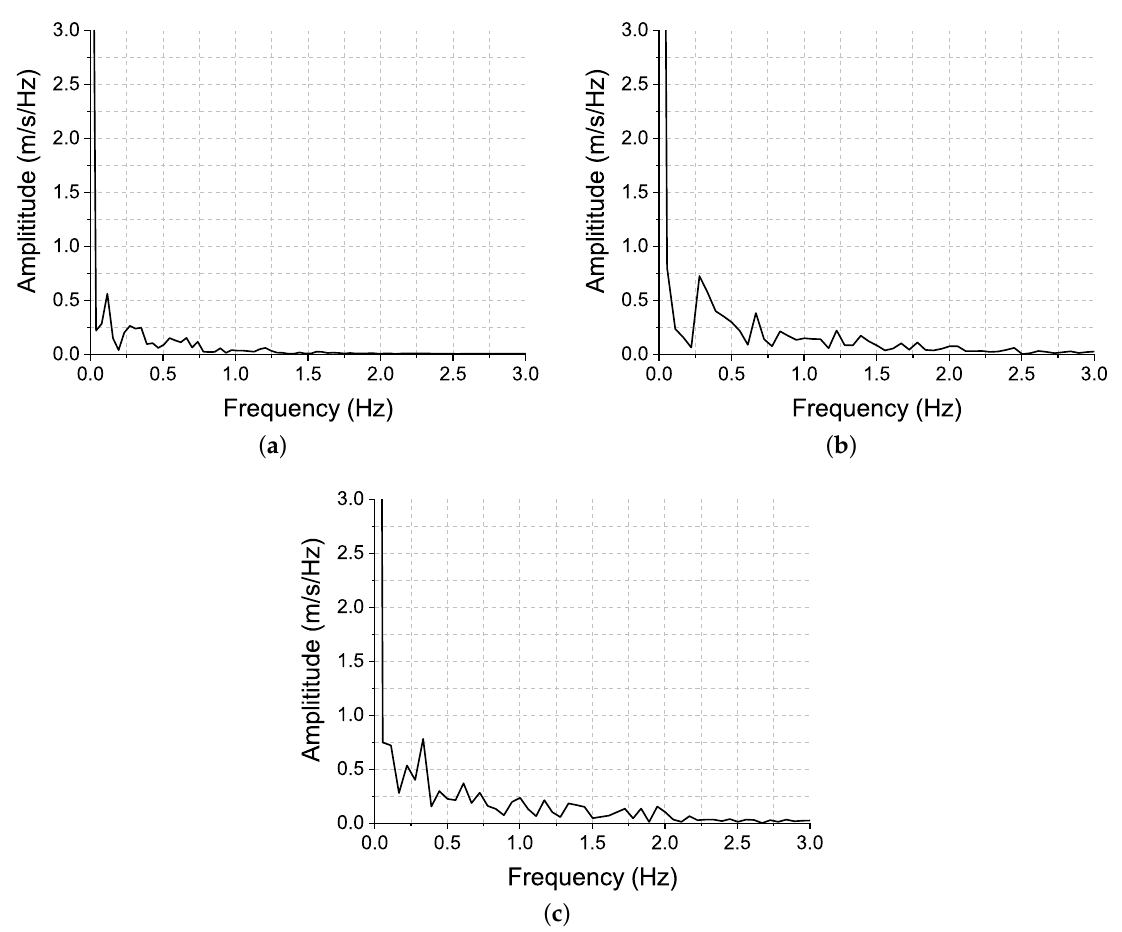
Figure 8. Variation of V N in frequency domain with stable inlet flow. ( a ) Case 1 (Stable 5m/s). ( b ) Case 2 (Stable 9m/s). ( c ) Case 3 (Stable